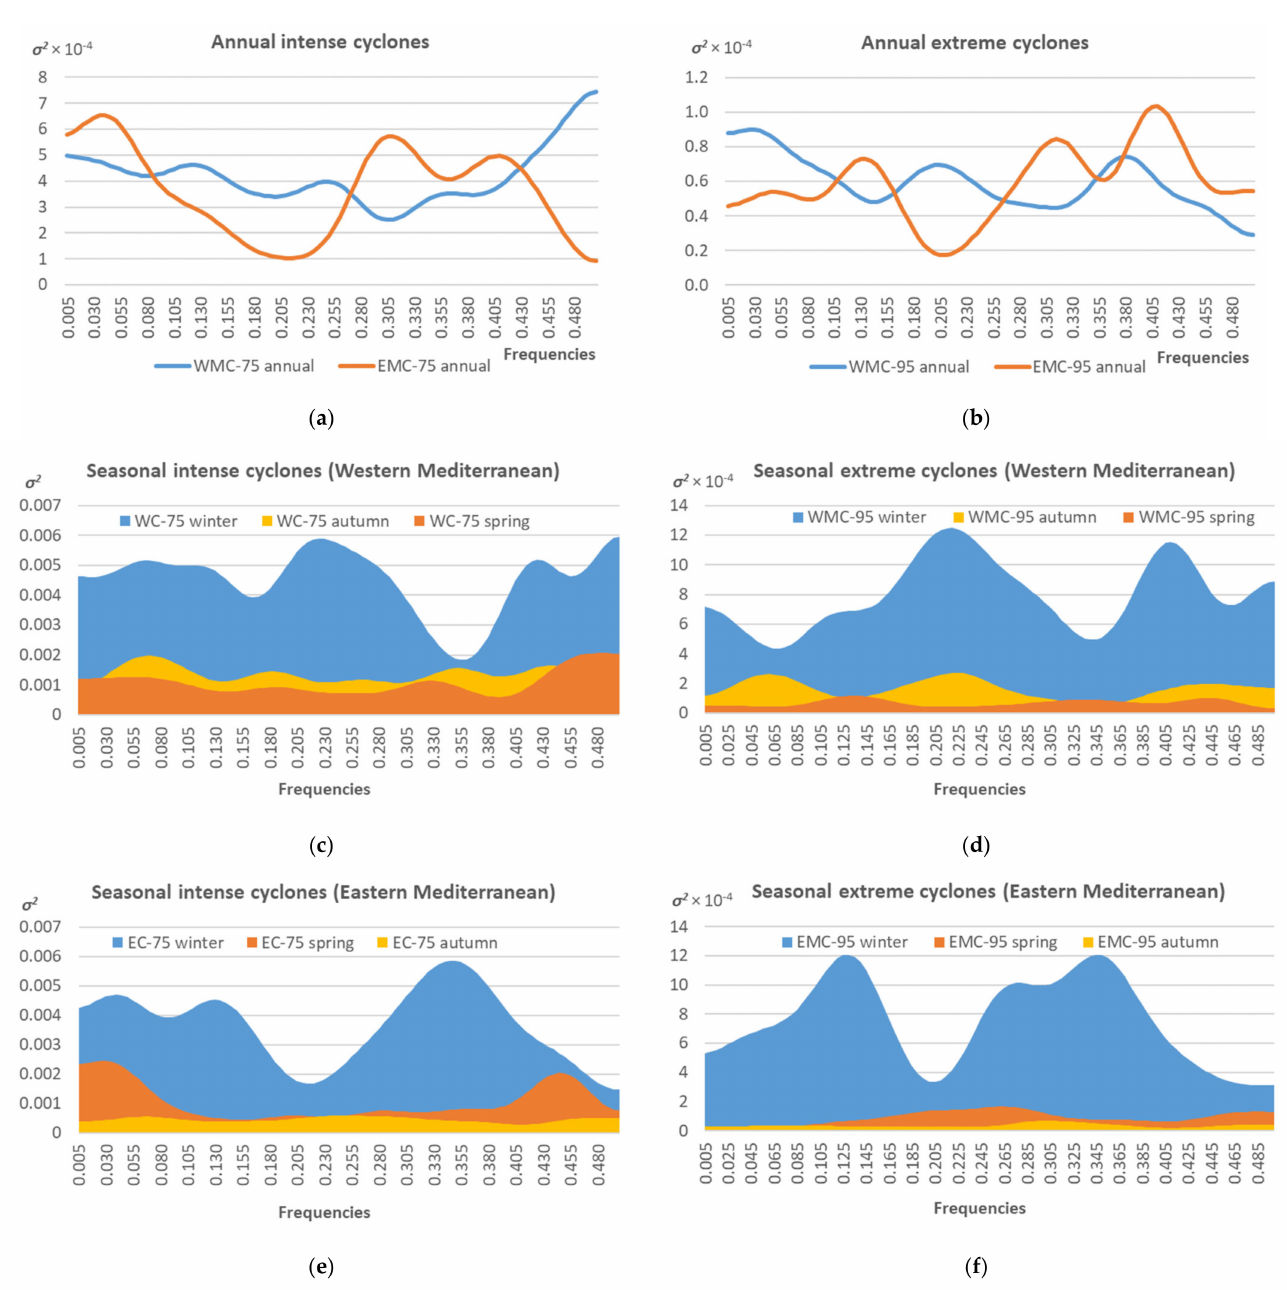
Figure 7. Averaged periodograms of annual ( a , b ) and seasonal ( c – f ) values of the frequency of intense/extreme cyclones over the Western and Eastern Mediterranean (WMC-75/WMC-95 and EMC-75/EMC-95, respectively): ( a , c , e ) intense cyclones; ( b , d , f ) extreme